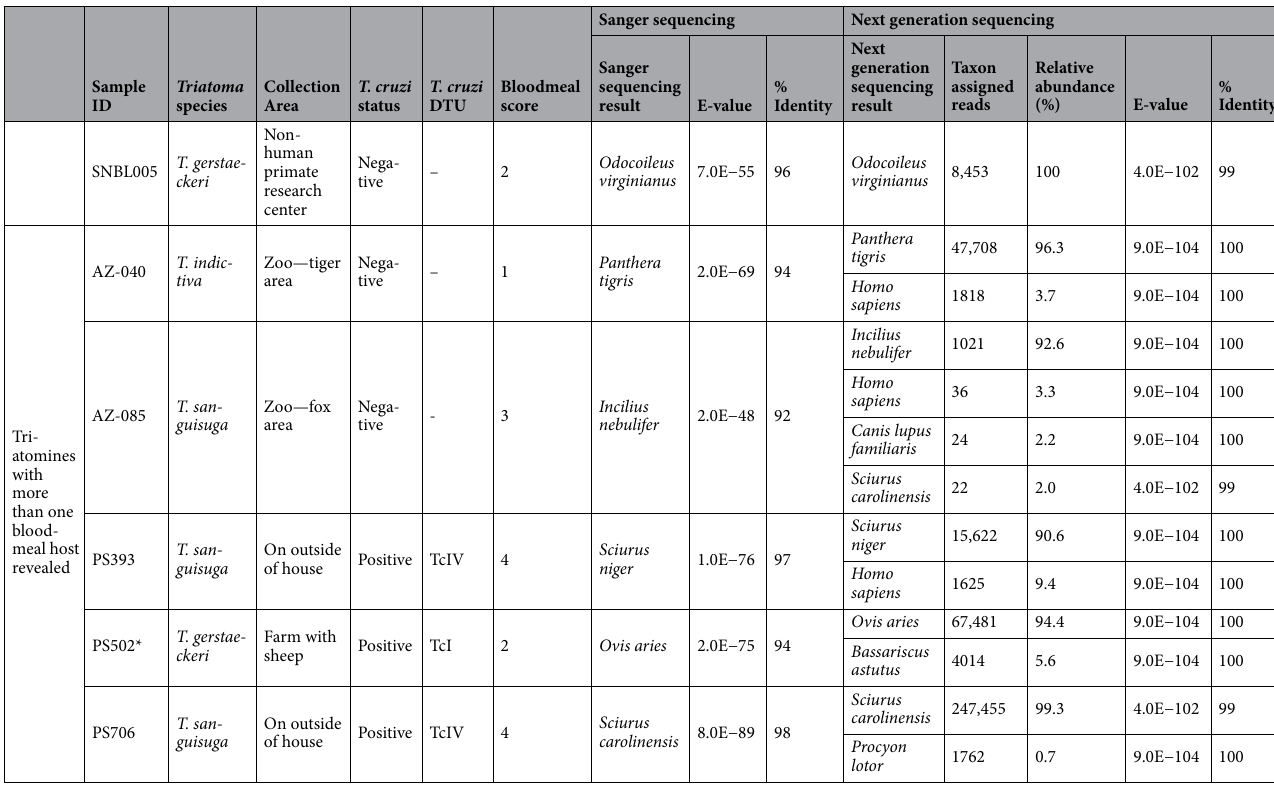
Table 2. Triatomine sample information for specimens with bloodmeal host result determined by direct Sanger and NGS methods. *998 reads in this sample identified Colobus guereza . The plausibility of this host in this sample was not verifiable and therefore, these were set aside from consideration. Ecological data and vertebrate bloodmeal host identifications based on direct Sanger sequencing versus amplicon deep sequencing for 36 triatomines collected across Texas and